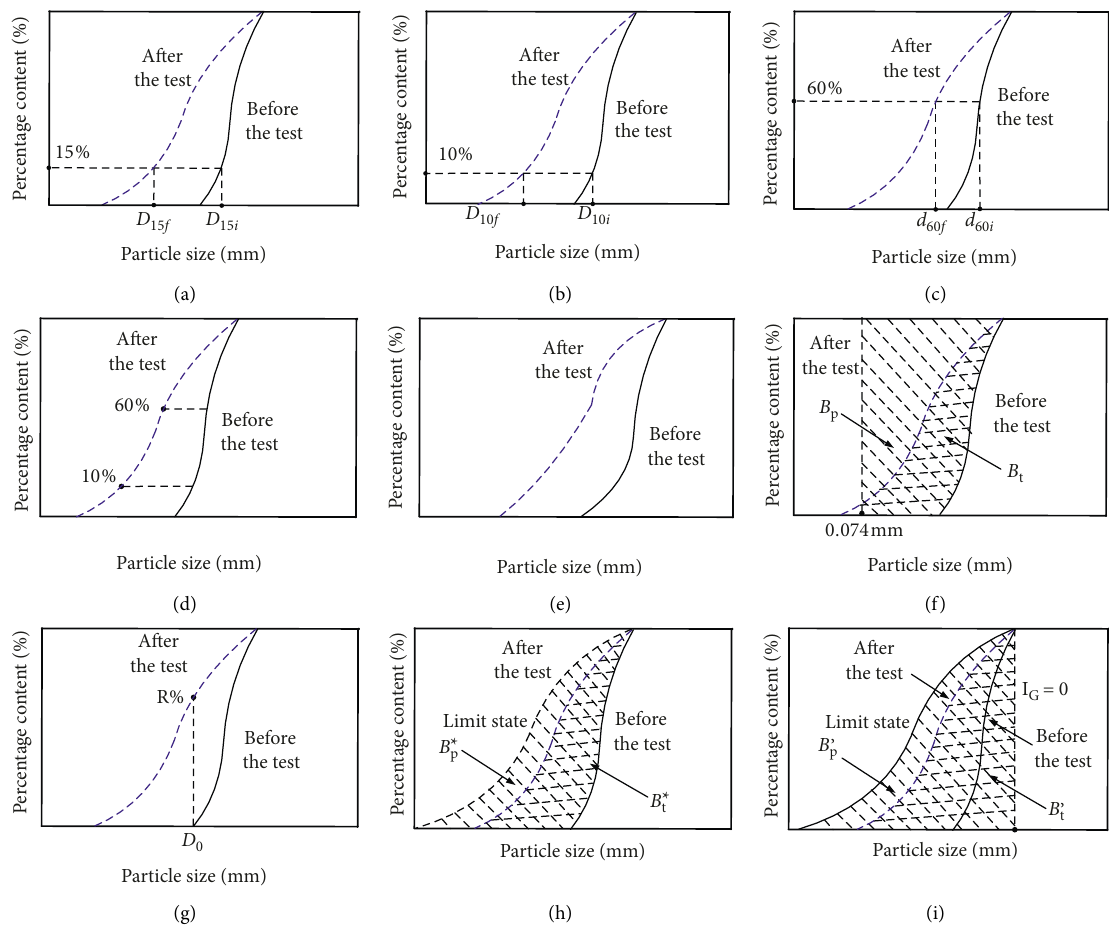
Figure 3: Sketch of definitions of different particle breakage description methods: (a) Lee et al.; (b) Lade et al.; (c) Bai et al.; (d) Biarez et al.; (e) Marsal; (f) Hardin; (g) Nakata et al.; (h) Einav; (i) Wood et